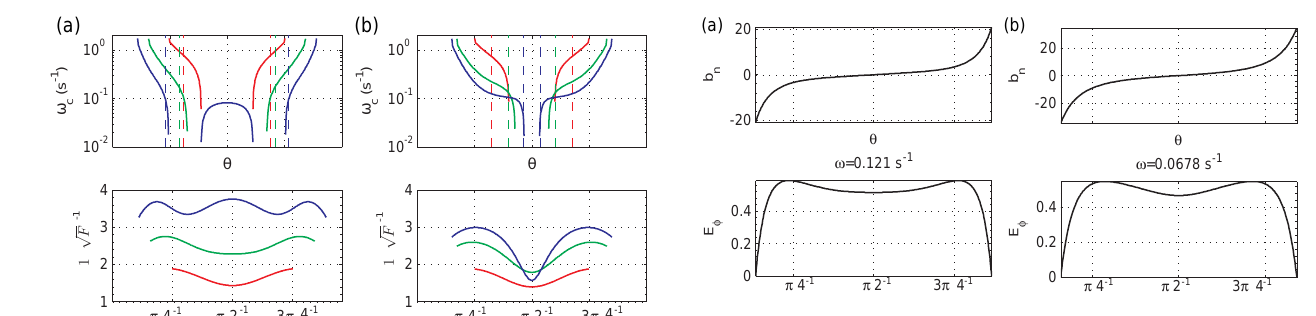
Figure 10. Wave forms of the poloidal fundamental mode ( L = 5) on the (a) noon( φ = 0) and (b) midnight ( φ = π ) meridional plane, respectively. Format is the same as Fig. 8.